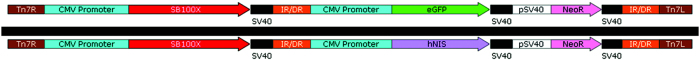
The schematic of constructed plasmids.The eGFP and NIS gene both driven by a CMV promoter were inserted into two IR/DR sites whereas SB100X driven by a CMV promoter was outside the two IR/DR sites in a single plasmid. CMV promoter = cytomegalovirus promoter, IR/DR = inverted repeat/direct repeated sequence, SB100X = Sleeping Beauty 100X.